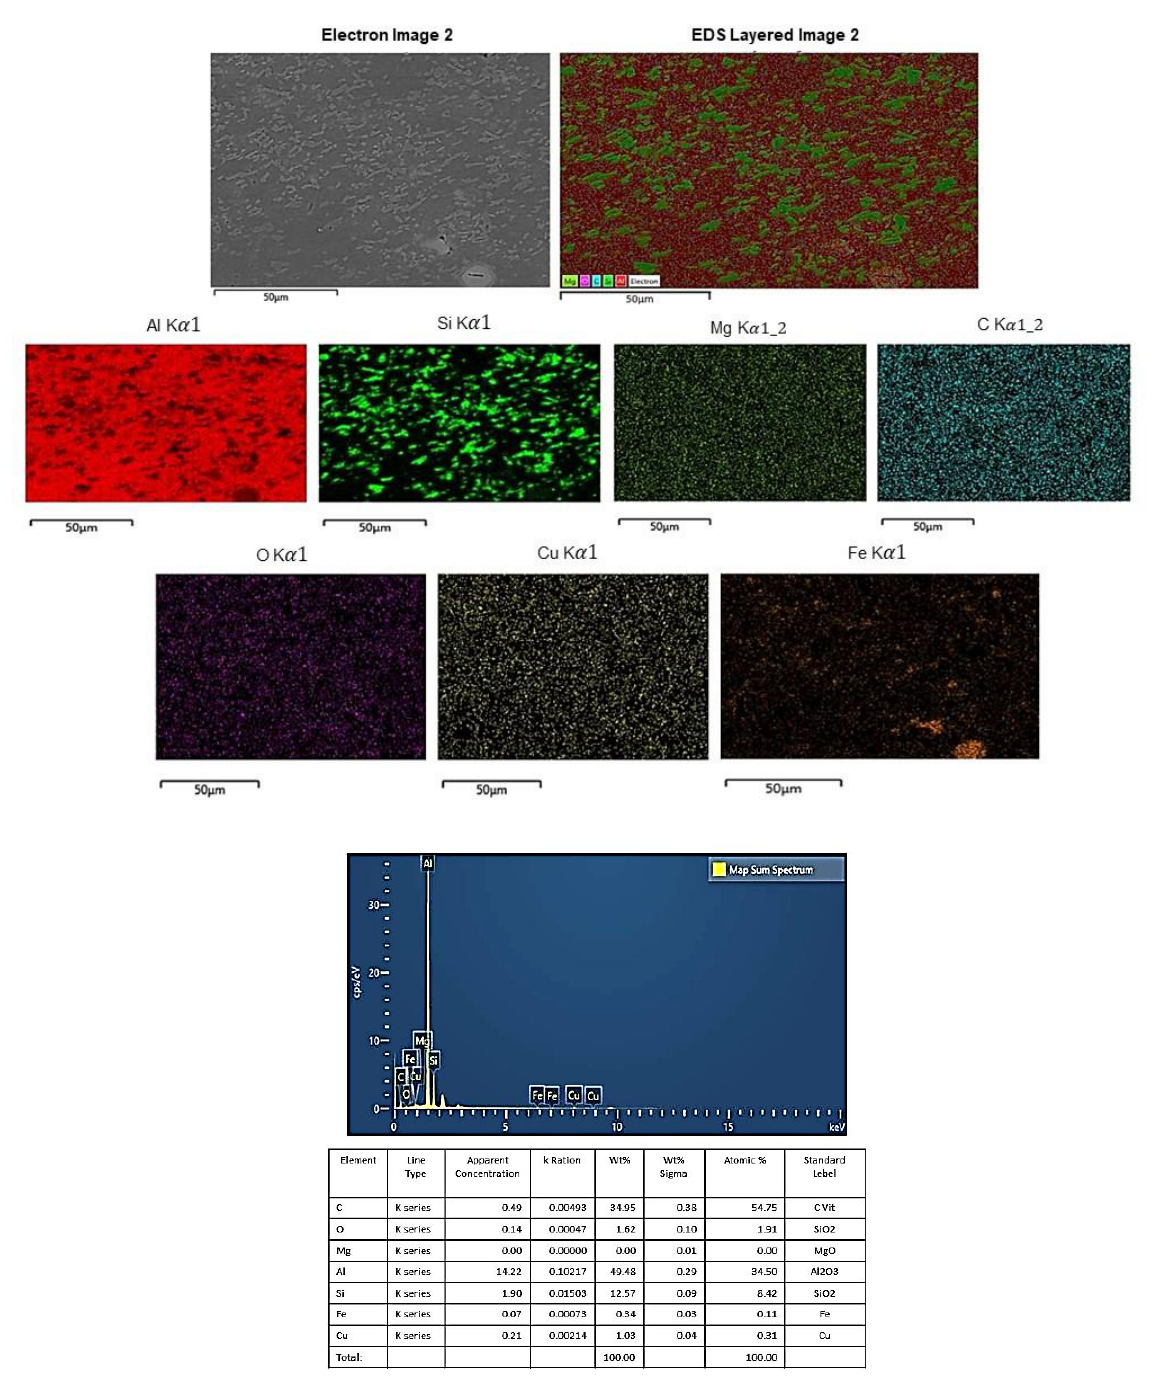
Figure 15. The EDX-ray spectroscopy of alloying elements at rotation speed 1469.44 rpm, welding speed 80.35 mm/min, tilt angle 1.01°, cylindrical tool, and clockwise direction.